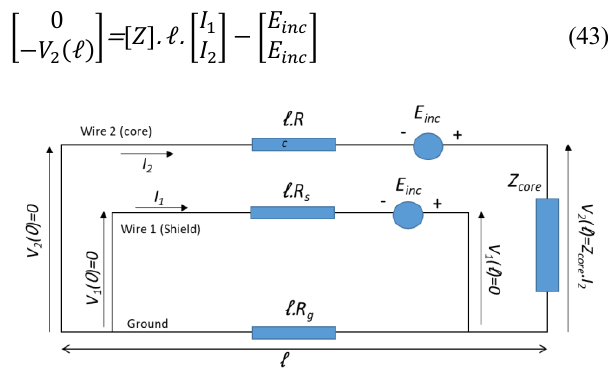
FIGURE 10. Low frequency circuit model of the shielded-cable with specific load configuration The development of (43), using (8)